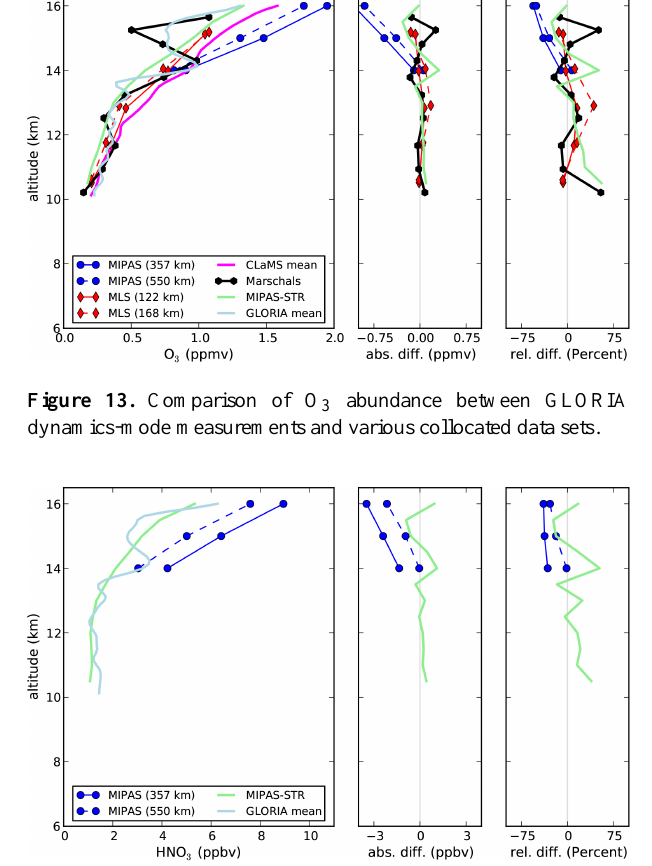
Figure 14. Comparison of HNO 3 abundance between GLORIA dynamics-mode measurements and collocated data sets.